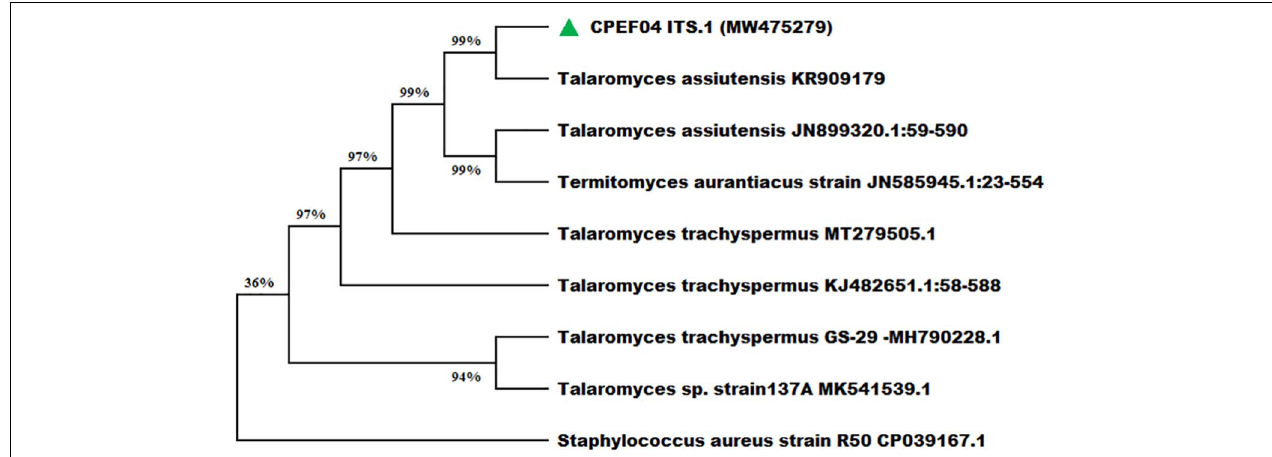
FIGURE 4 | Phylogenetic relationship of endophytic isolate CPEF04 based on ITS1, 5.8S rDNA, and ITS2 regions of DNA sequences. The maximum composite likelihood substitution model was used for phylogenetic reconstruction. The numbers on the tree branches indicate the percentage of bootstrap replications derived from 1,000 replications.